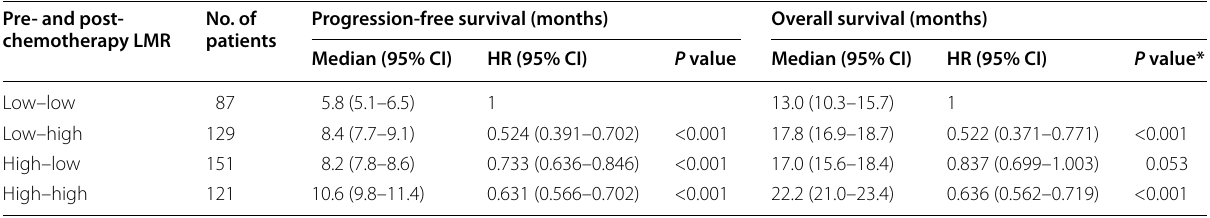
Table 4 Changes in LMR and benefits of chemotherapy